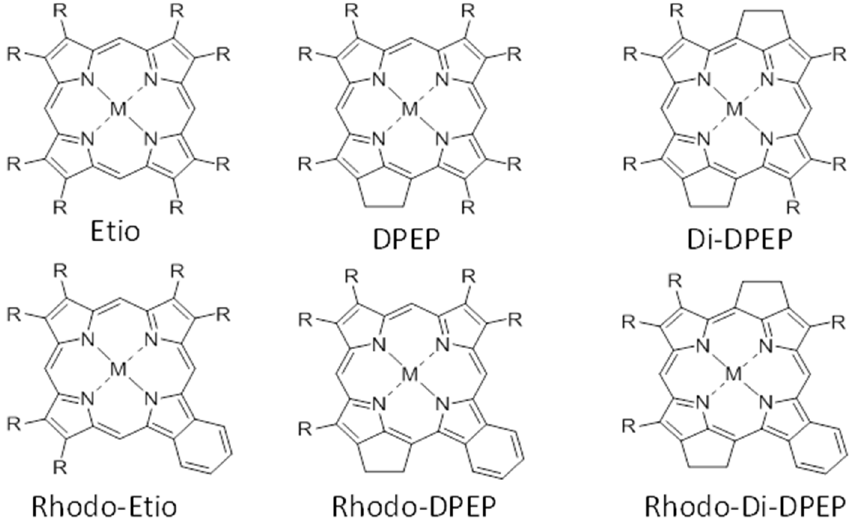
Figure 8. Representatives of the most common types of petroleum porphyrins.